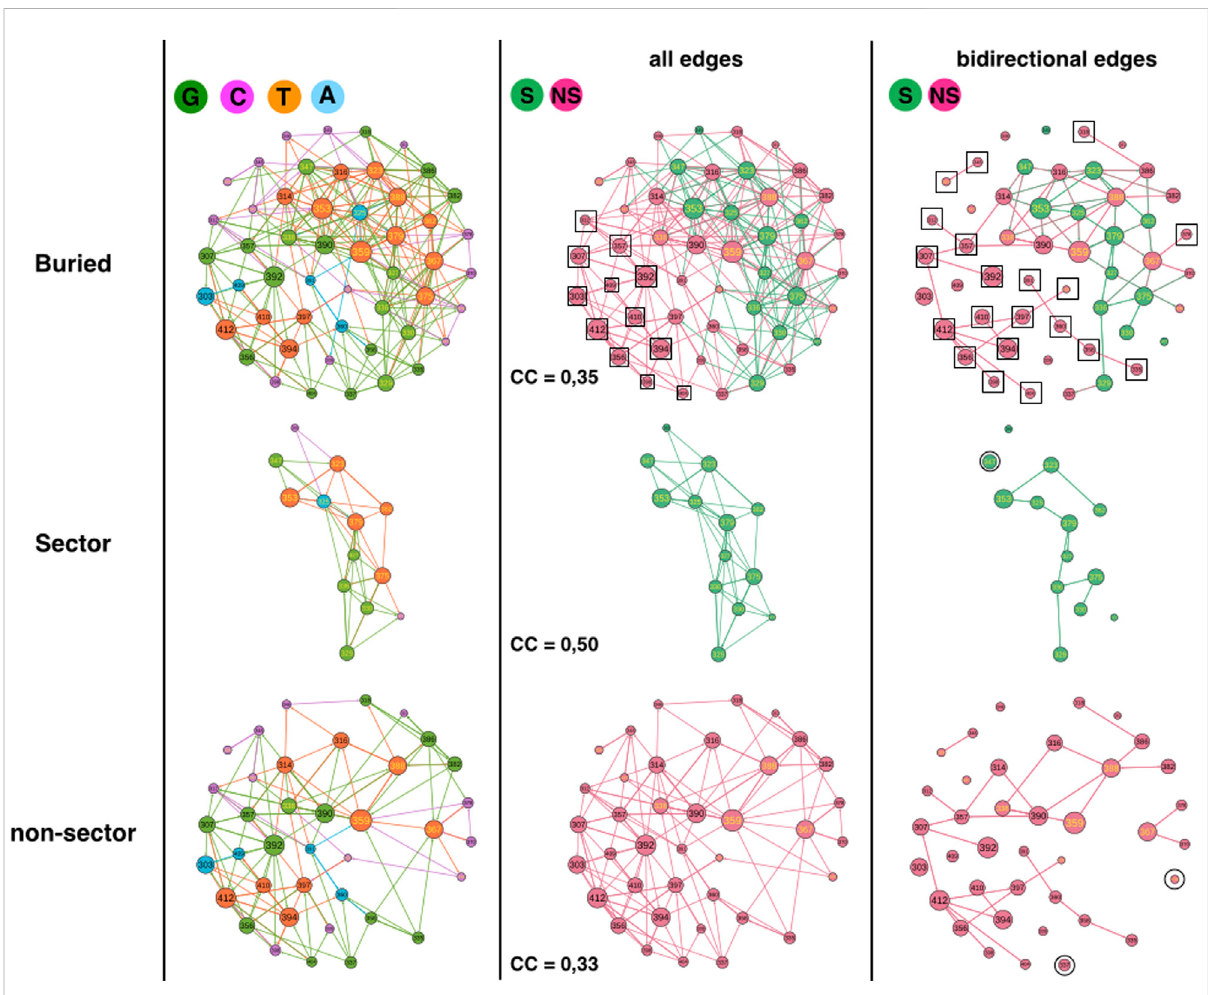
FIGURE 3 1BE9 GCAT network features of sector and non-sector sub-networks. The buried network, the sector and non-sector GCAT sub-networks are shown on the upper, middle and lower panels, respectively. The left, middle and right columns are the GCAT classi fi cation, all in fl uences and bidirectional mutual in fl uences, respectively. The square boxes indicate nodes that are involved in homogeneous in fl uences only (i.e., edges sector tosectororedgesnon-sectortonon-sector),thecirclesindicatenodesthatareinvolvedinheterogeneousin fl uencesonly(i.e.,edgessectorto non-sector or edges non-sector to